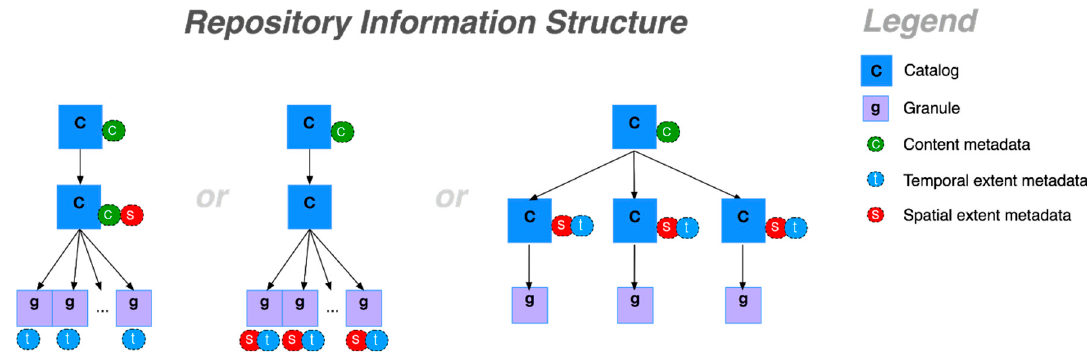
Figure 6. Repository information model.